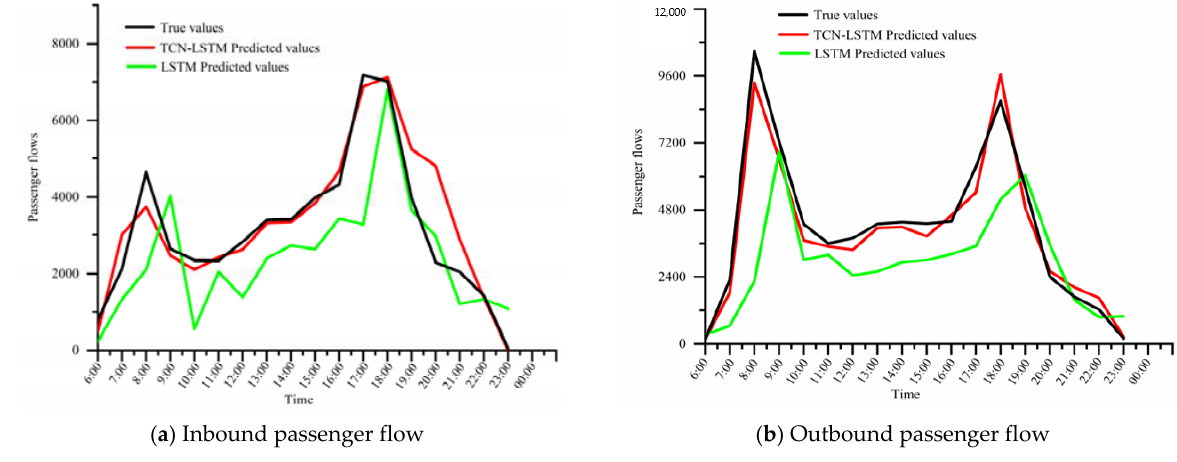
Figure 14. Prediction results of passenger flow at Guanyinqiao (high passenger flow).